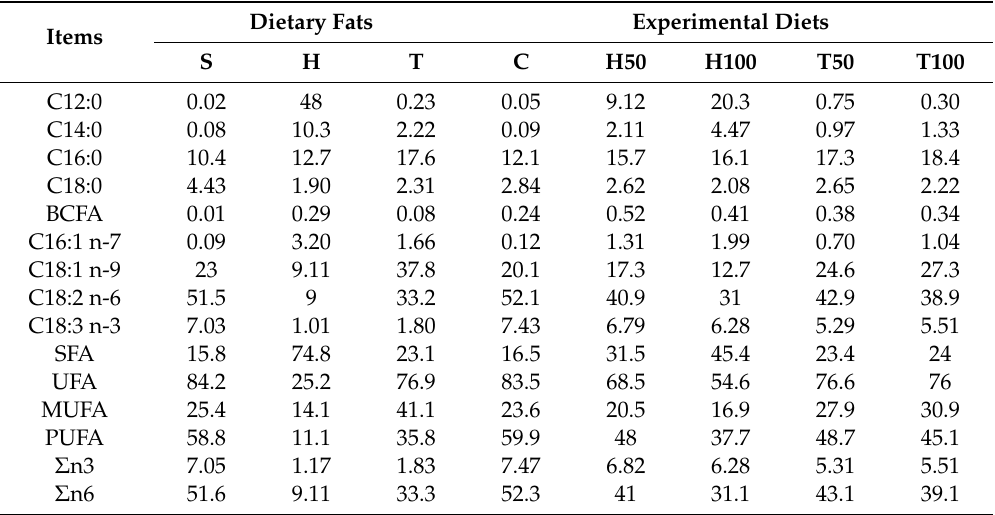
Table 2. Fatty acid profile of the dietary fats and experimental diets (% of total FAME) (modified from Gasco et al.